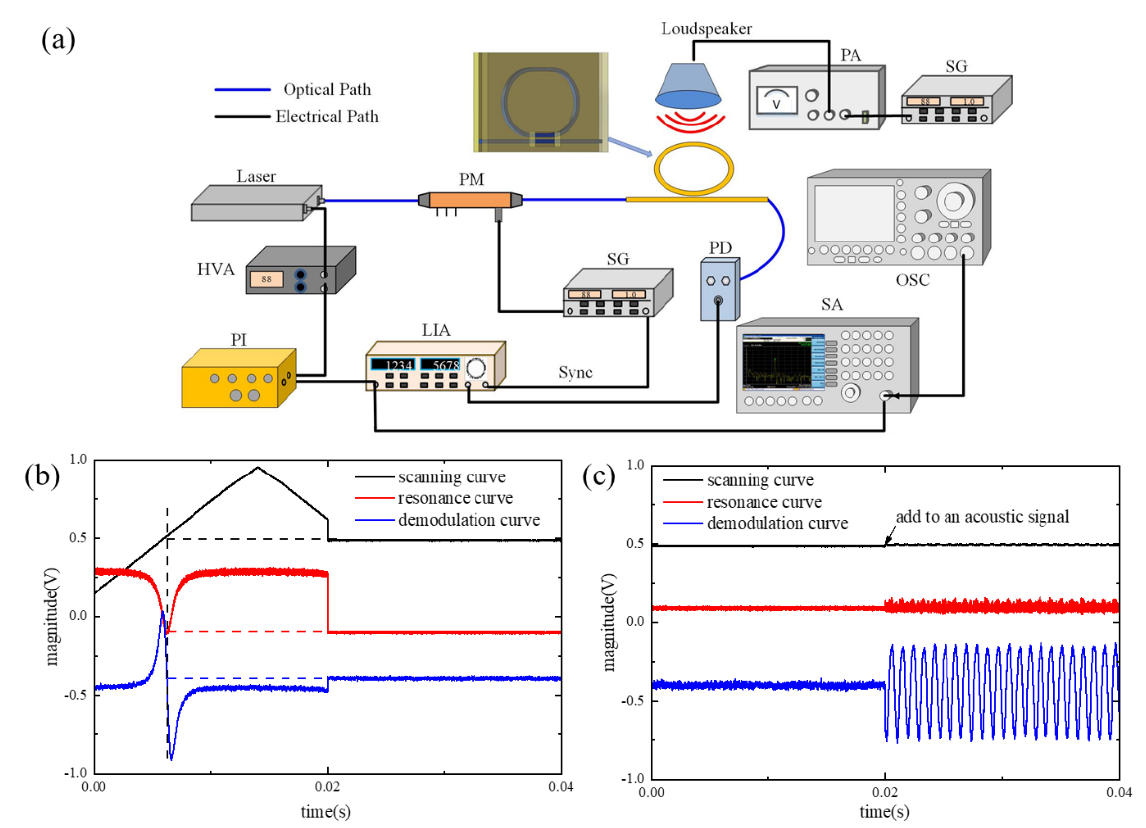
Figure 4. ( a ) The experimental test system of the ring resonators. PM, phase modulator; SG, signal generator; PD, photodetector; LIA, lock-in amplifier; PI, lock-frequency controller; HVA, high volt- age amplifier; OSC, oscilloscope; SA, frequency spectrum analyzer; PA, power amplifier. Here, blue lines are the optical path, and black lines are the electrical path. ( b ) Optical spectral lines and fre- quency-locking curves of the ring resonator of sensor 2. ( c ) The response of demodulation signal of sensor 2 when an acoustic signal is added into.